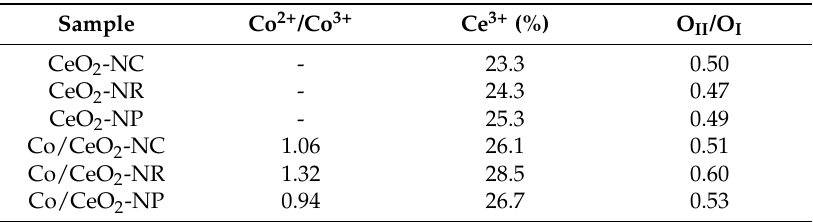
Table 3. The XPS results of bare CeO 2 and Co/CeO 2